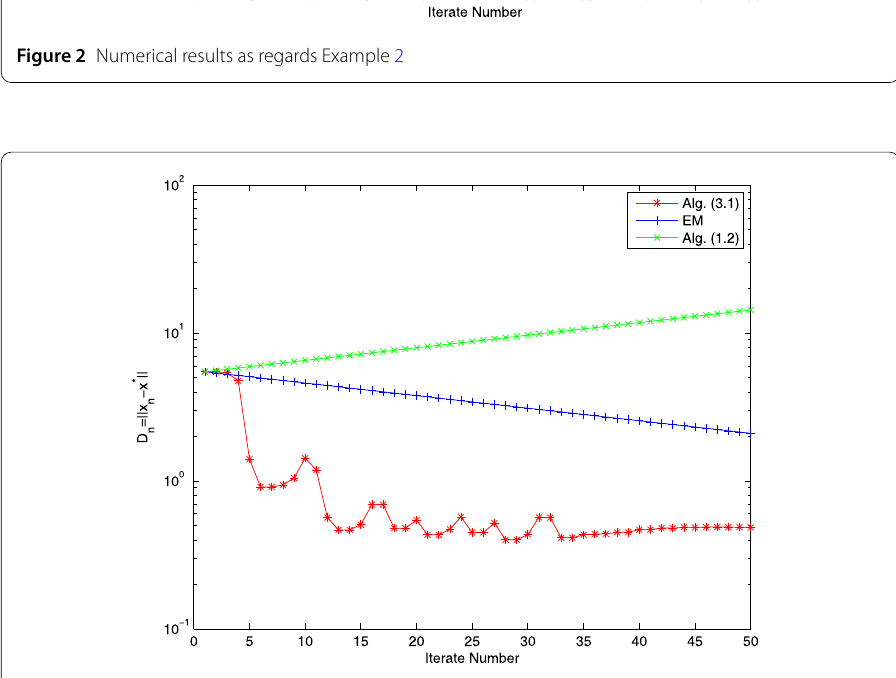
Figure 3 Numerical results as regards Example 2